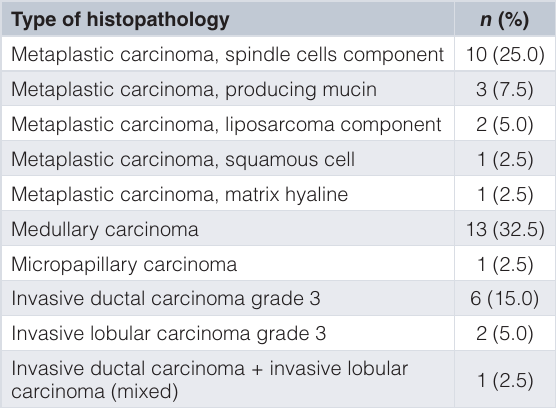
Table 1. Histopathology types of TNBC samples used in this study (N=40).